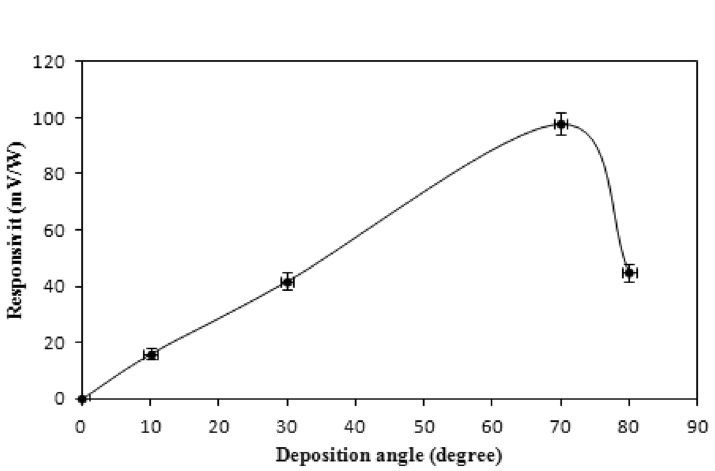
Figure 9. XRD patterns of antimony film deposited at θ = 70° before and after Ruby laser irradiation.